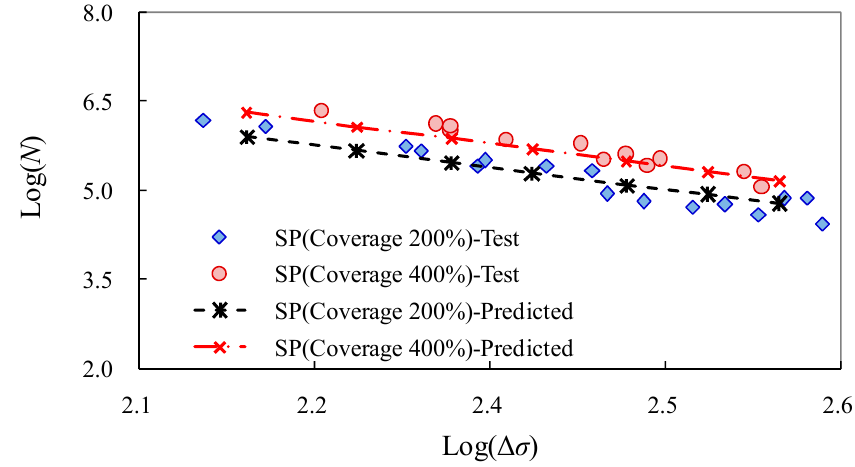
Figure 8. Comparison of test and predicted log( N )-log( Δσ ) curves.